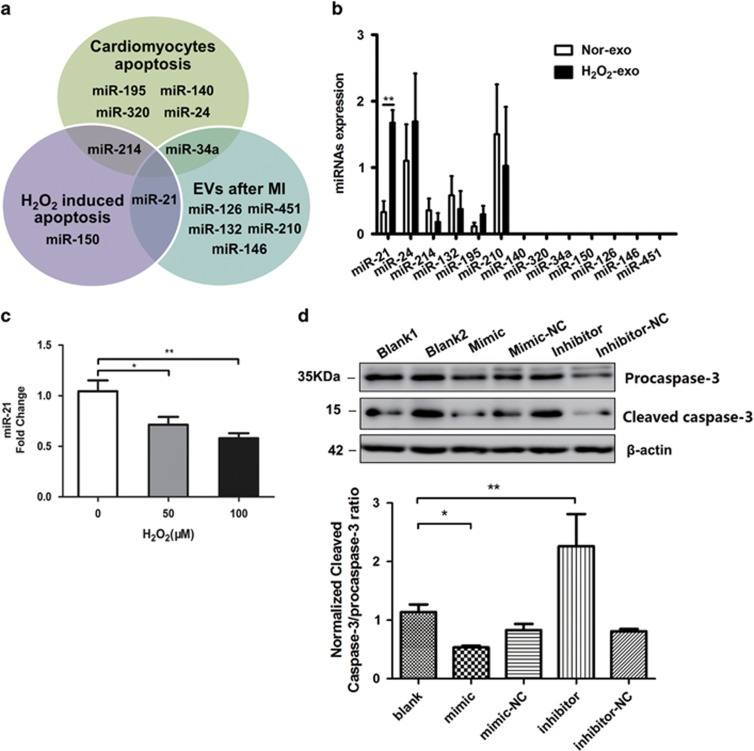
H2O2 changes the levels of miRNAs in CPC-exosomes. (a) Main reported miRNAs participated in cardiomyocytes apoptosis, H2O2 induced apoptosis and miRNAs contained in the EVs after myocardial infarction, some miRNAs are multifunctional in both fields, such as miR-21, miR-214 and miR-34a. (b) Quantitative PCR analysis of main reported miRNAs in Nor-exo and H2O2-exo, six miRNAs (miR-21, 24, 214, 132, 195, 210) are founded in H2O2-exo, and only miR-21 was significantly upregulated (N=6, **P<0.01 versus Nor-exo). (c) RT-qPCR analyzed and miR-21 in H9C2 cells after different concentrations of H2O2 treated (N=3, *P<0.05, **P<0.01 versus 0 μM). (d) 100 μM H2O2-treated H9C2 cells transfected with miR-21 mimics, inhibitors and both negative controls, and western blotting analyzed procaspase-3 and cleaved caspase-3 proteins levels in H9C2 cells (N=5, **P<0.01, ***P<0.001 versus blank group)